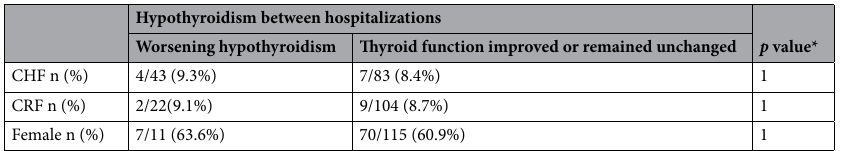
Table 3. Heart and renal failure and hypothyroidism worsening between hospitalizations. CHF congestive heart failure, CRF chronic renal failure. *Fisher’s Exact Test.